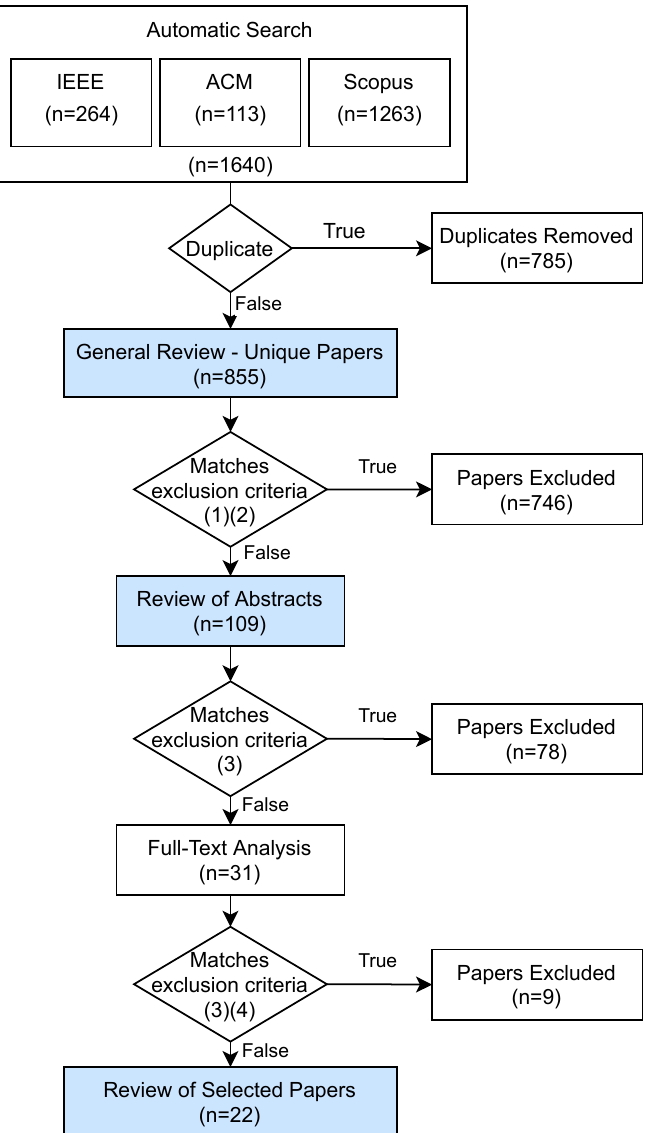
Figure 1. Systematic Review